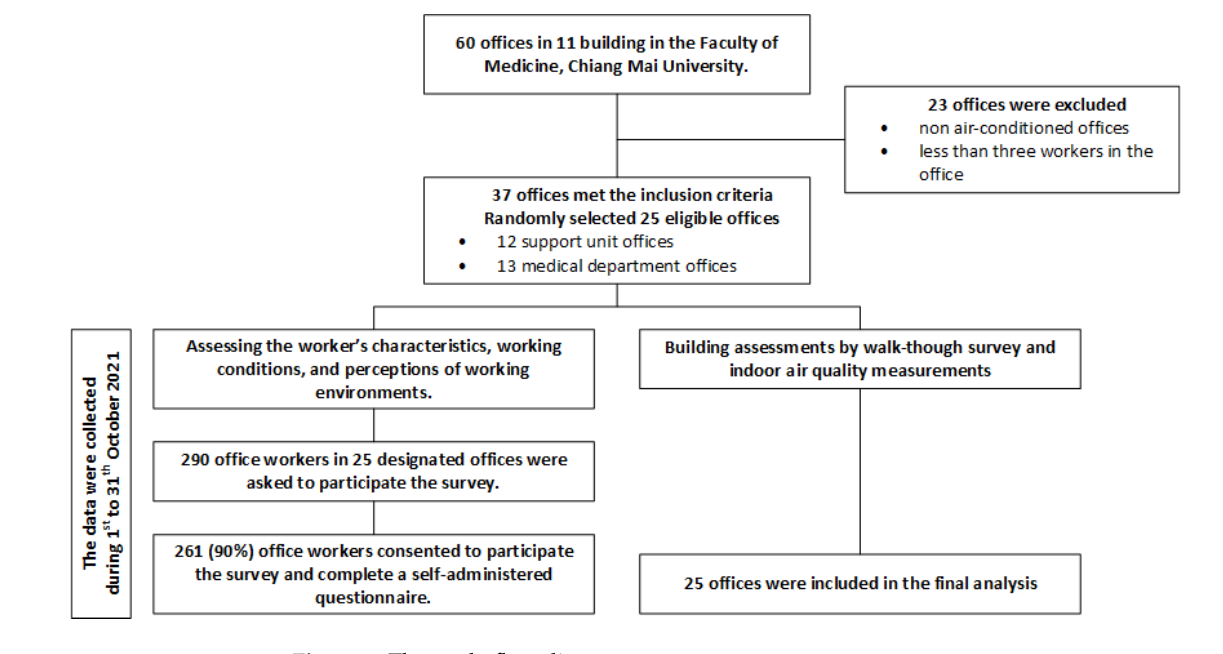
Figure 1. The study flow diagram.